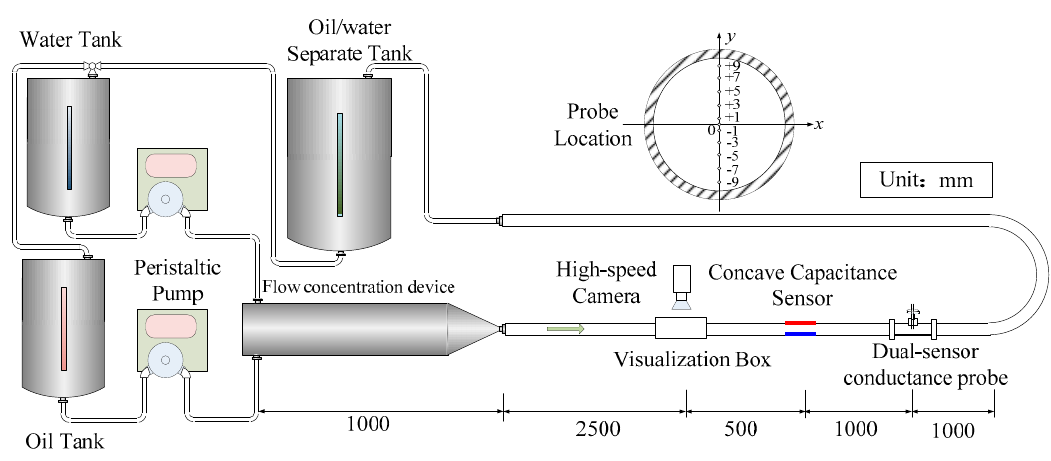
Figure 11. Schematic diagram of the experimental setup for horizontal oil–water two-phase flow.